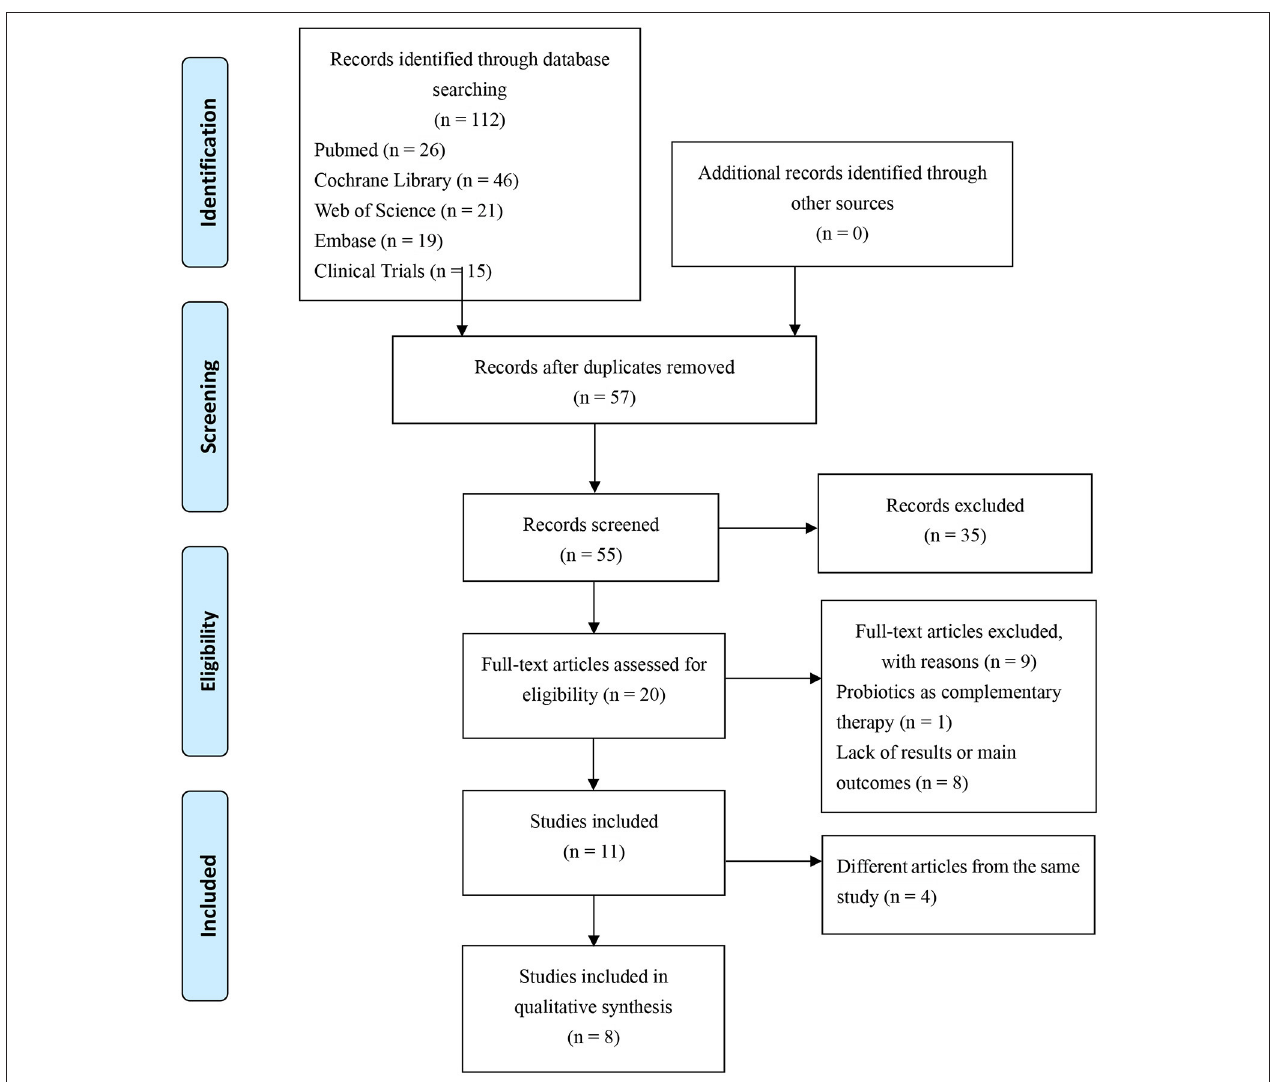
FIGURE 2 | Flow diagram of study